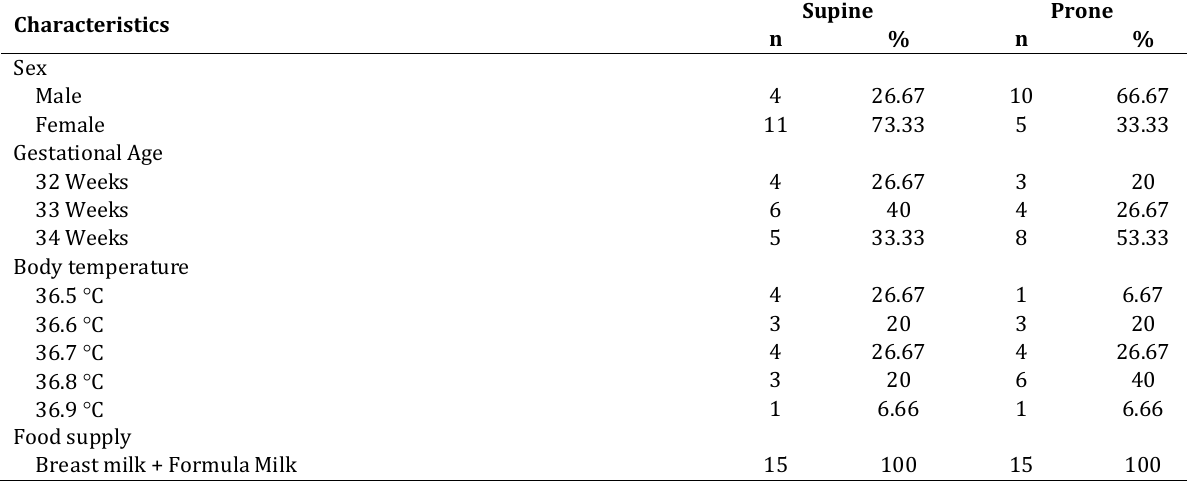
Table 1. Characteristic Demographic (n=30)